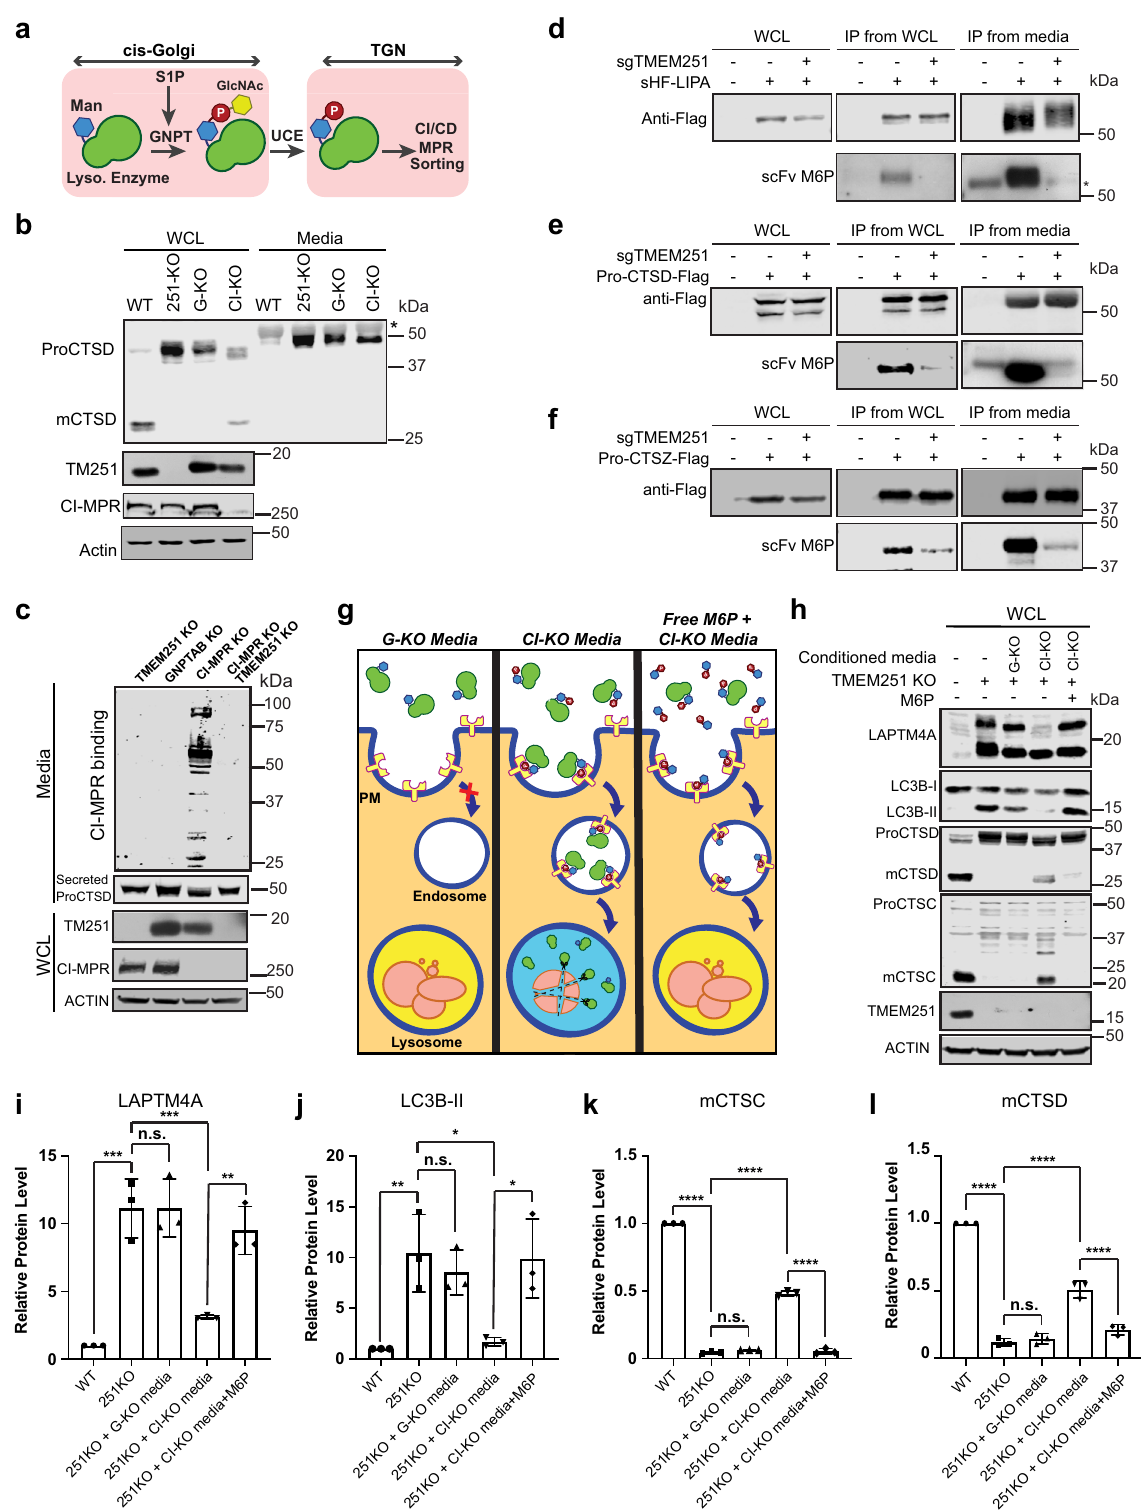
Fig. 5 | TMEM251 de fi ciency leads to M6P modi fi cation defects of lysosomal enzymes. a A schematic representation of M6P modi fi cation and sorting of lyso- somal enzymes. b CTSD protein level in the whole cell lysate and conditioned mediaofHEK293TWT,TMEM251KO(251-KO),GNPTABKO(G-KO),CI-MPRKO(CI- KO) cells ( n =3 independent replicates). Asterisk: a non-speci fi c band. c CI-MPR binding assay of conditioned media from TMEM251 KO, GNPTAB KO, CI-MPR KO, and CI-MPR and TMEM251 double KO cells ( n =3 independent replicates). d – f Detection of M6P modi fi cation of LIPA ( d ), CTSD ( e ), and CTSZ ( f ) in HEK293T